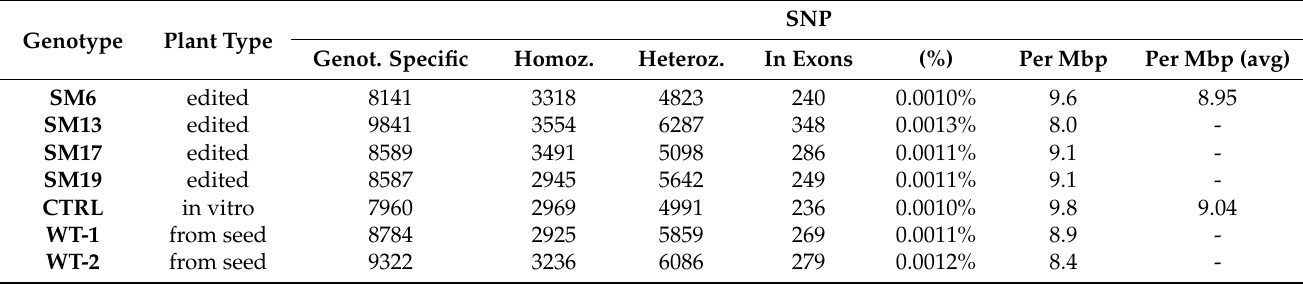
Table 4. SNP statistics for each Illumina-sequenced